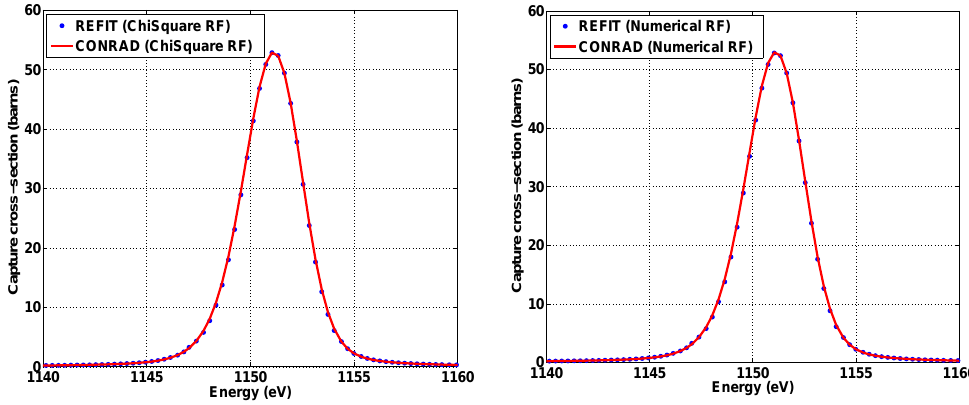
Figure 2. Comparisons of 26 Fe capture cross-sections (FGM at T ef f = 293 . 6 K) between CONRAD and REFIT with the analytical ( χ 2 with λ = 5 . 83 mm) and numerical resolution